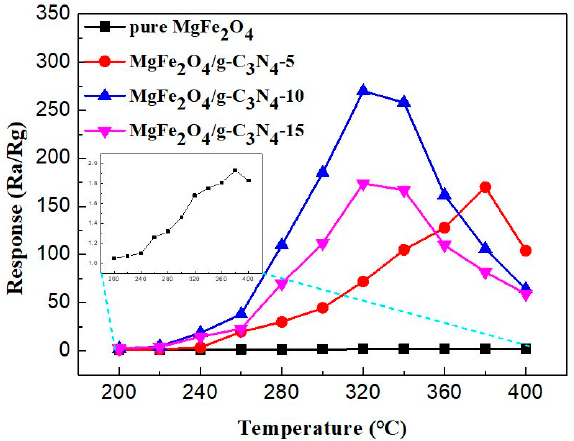
Figure 6. Response values of the sensors based on pure MgFe 2 O 4 , MgFe 2 O 4 /g-C 3 N 4 -5, MgFe 2 O 4 /g-C 3 N 4 -10 and MgFe 2 O 4 /g-C 3 N 4 -15 composites to 500 ppm acetone as a function of operating temperature.